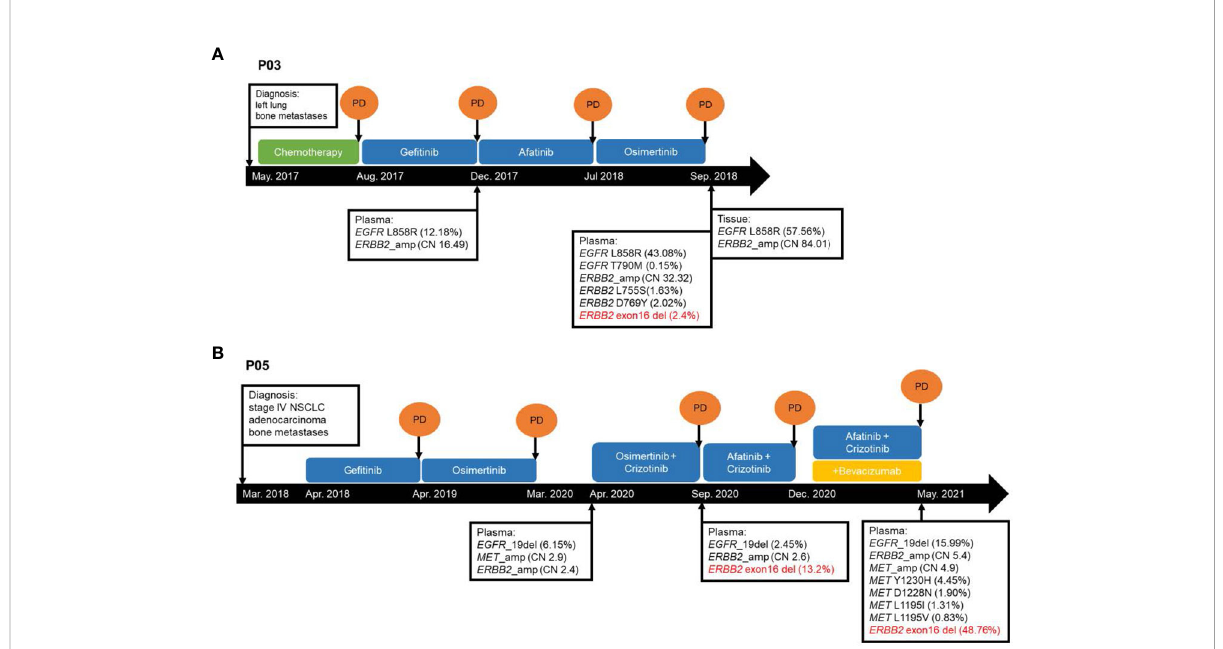
FIGURE 3 Schematic presentation of the courses of management for two ERBB2 D Ex16+ lung cancer patients (A) P03 and (B) P05 from Cohort 1. CN, copy number. NSCLC, non-small cell lung cancer. PD, progressive